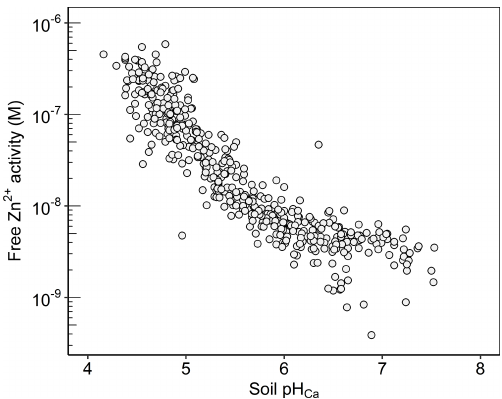
Figure 9. Concentration of the free Zn 2 + activity in the soil solu- tion as a function of soil